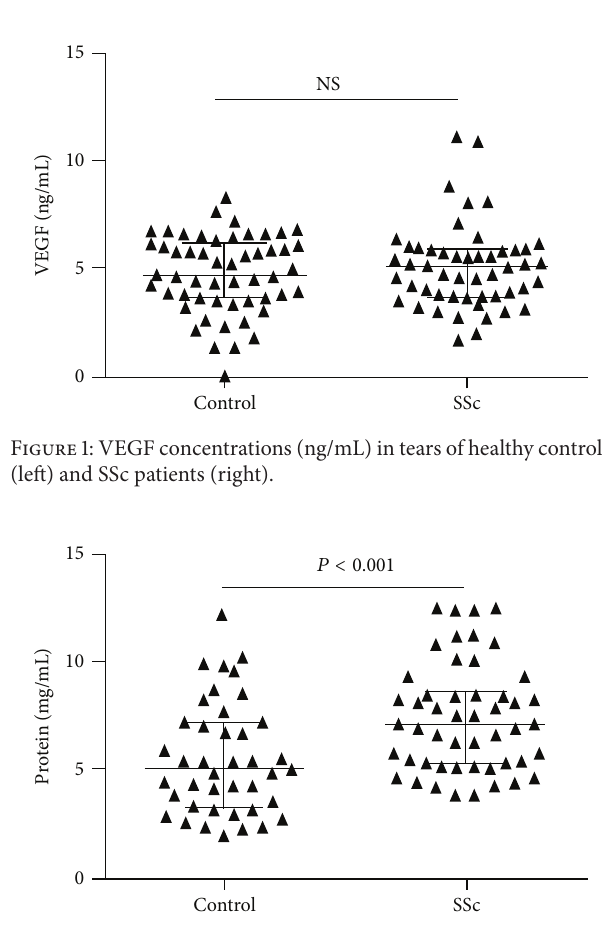
Figure 2: Total protein concentrations (mg/mL) in tears of healthy controls (left) and SSc patients